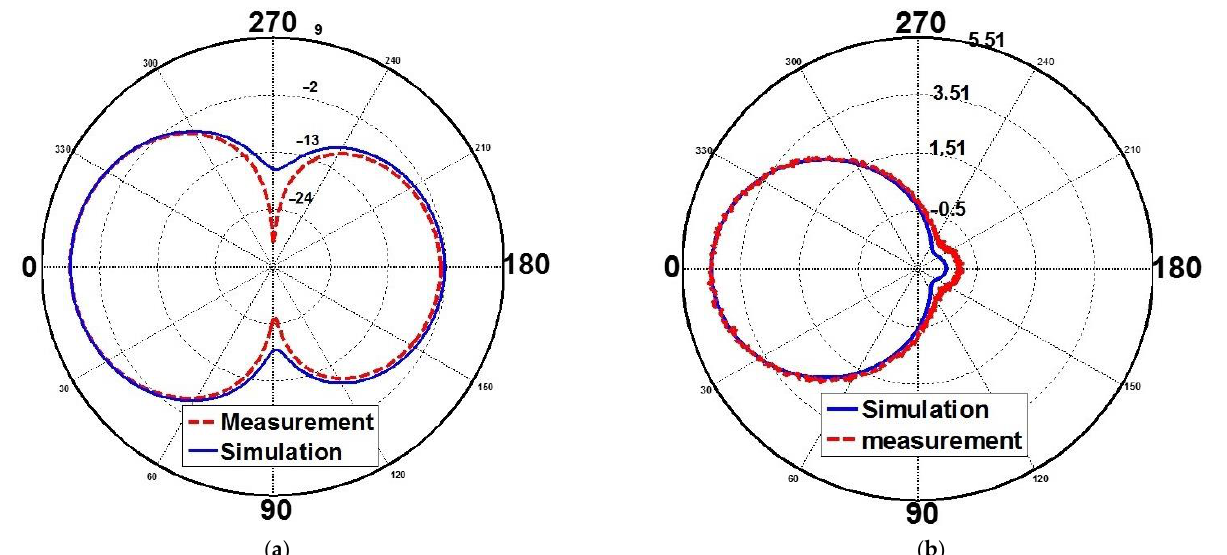
Figure 7. Simulation and measurement results of the radiation pattern of the CPW antenna over proposed MD-AMC board for ( a ) E-plane, and ( b ) H-plane.